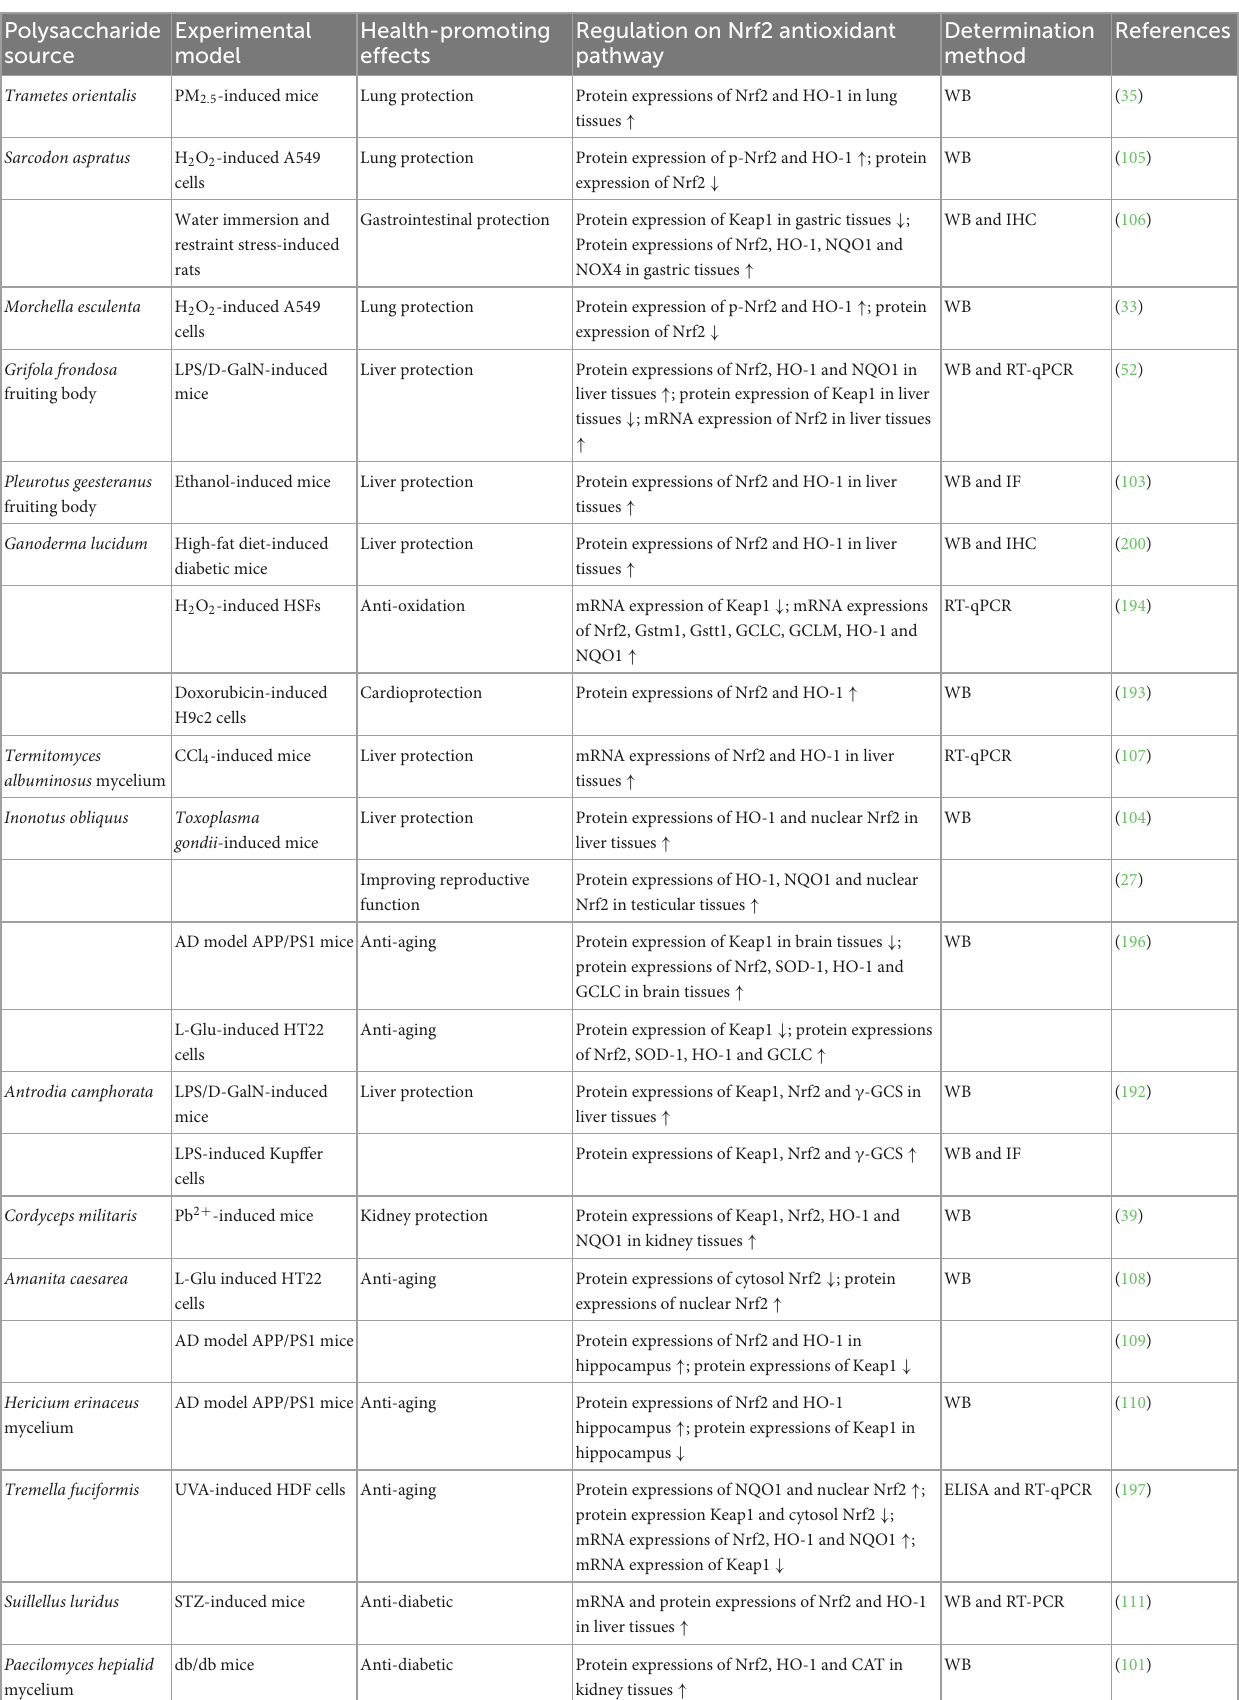
TABLE 4 Regulation of NPs from fungi on Nrf2 antioxidant pathway for health-promoting